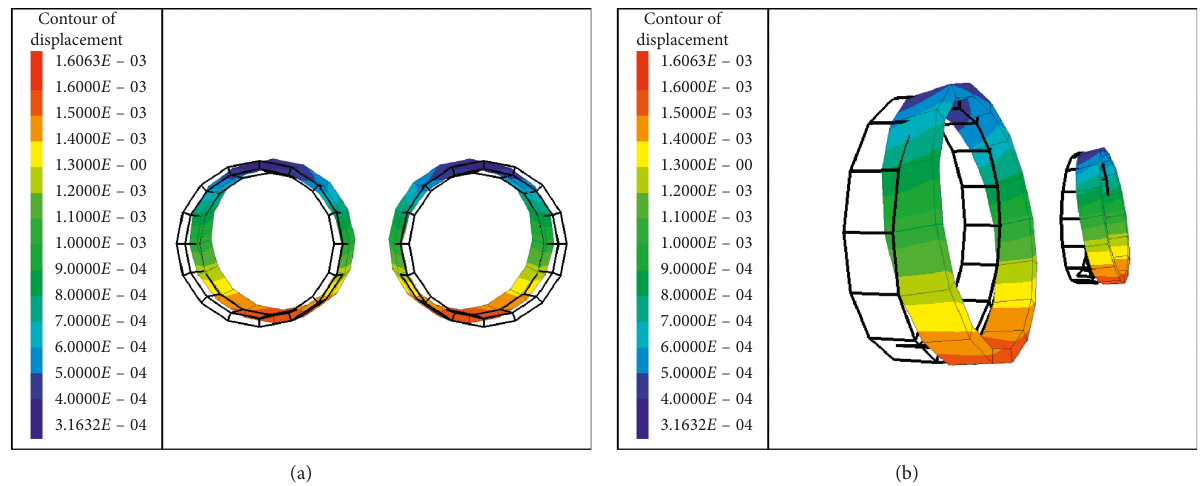
Figure 18: Deformation contour of pipe piece at Y � 55 (m). (a) Front view of pipe piece deformation at Y � 55m. (b) Side view of pipe piece deformation at Y � 55m.